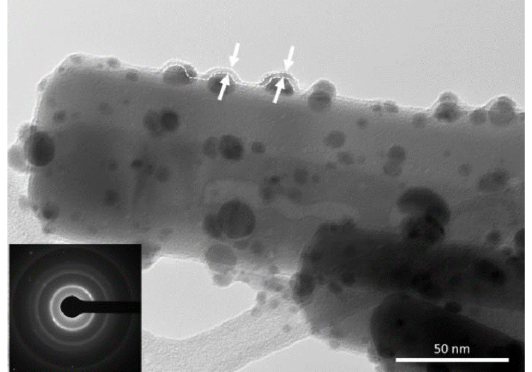
Figure 6. TEM images of PVDF/ZnO/Ag 2 CO 3 /Ag 2 O electrospun nanofiber; inset SAED pattern. (Reprinted from the work of Rosman et al. [28]).